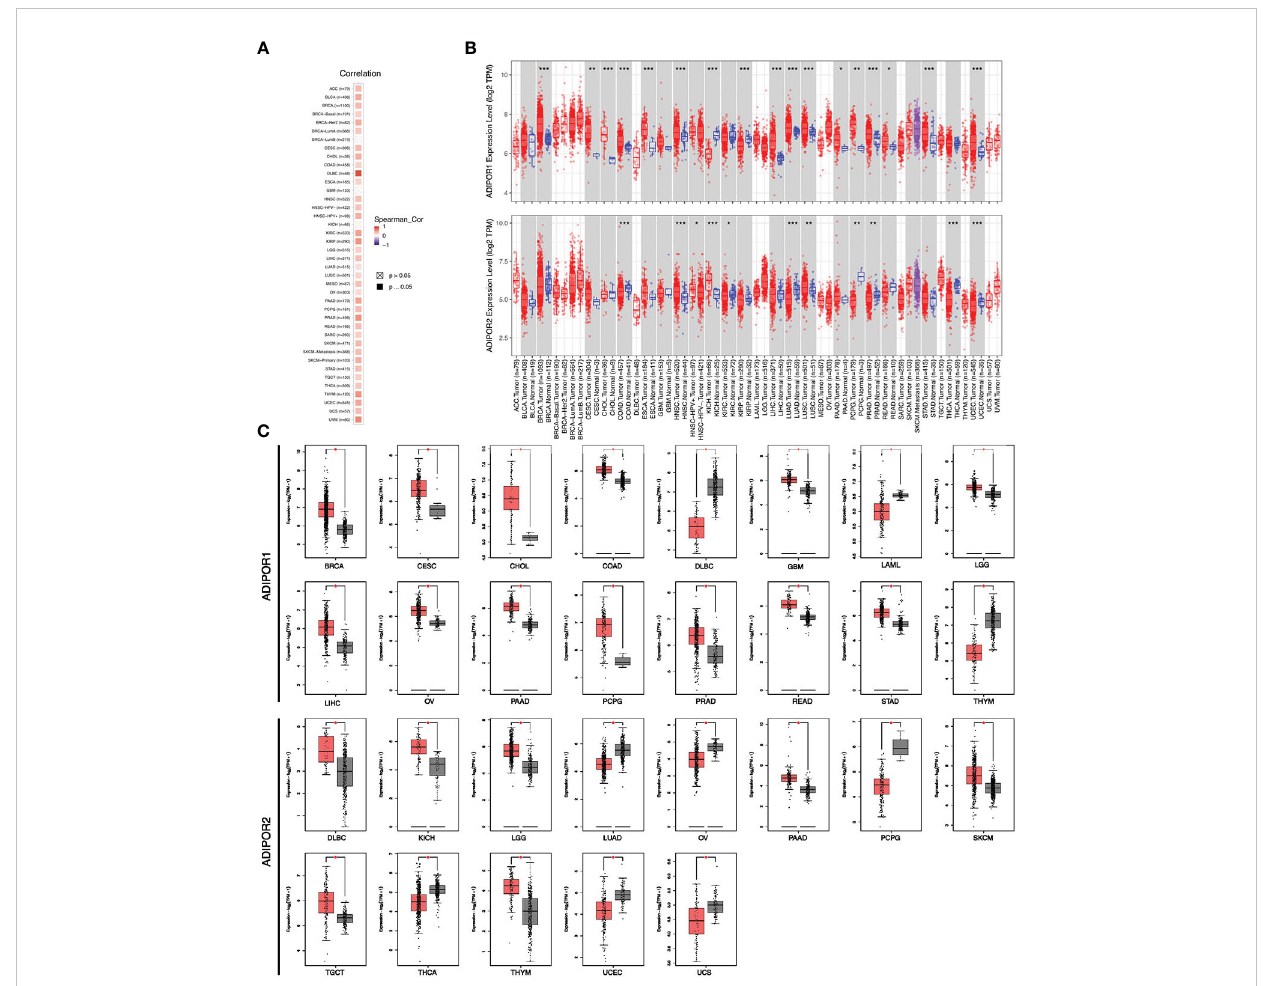
FIGURE 2 The expression of ADIPOR1 and ADIPOR2 across cancers. (A) The correlation between ADIPOR1 and ADIPOR2 across cancers. (B) The difference analysis ofADIPOR1 and ADIPOR2 across cancers via TIMER2.0 database. Red represented tumor samples, and black represented normal samples. *P < 0.05, **P< 0.001, ***P < 0.0001. (C) The difference analysis of ADIPOR1 and ADIPOR2 across cancers via GEPIA2 database. *P <